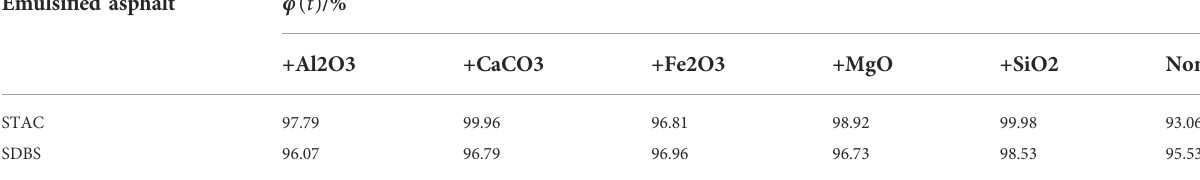
TABLE 7 φ ( t ) calculated for the emulsi fi ed asphalt-aggregate systems.